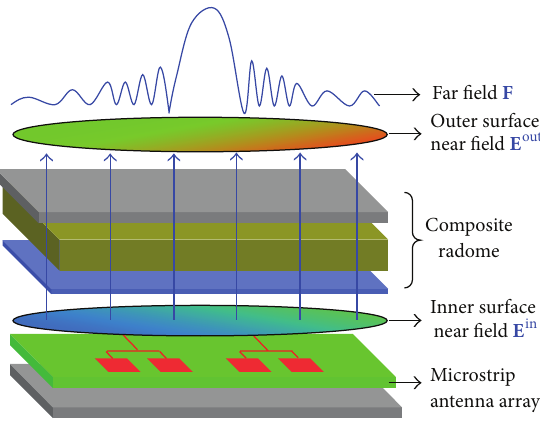
Figure 2: Analysis process of far field pattern of